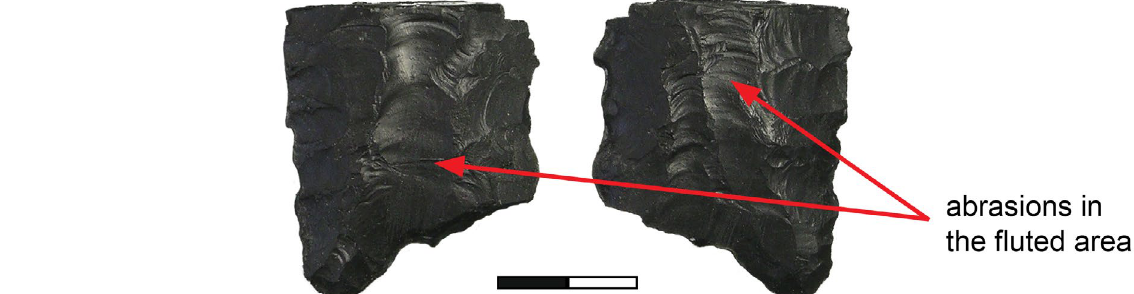
Figure 5. One of several Clovis-like fluted basal sections from the Borax Lake site, that displays the scratches in the fluted area on both faces (image after Slade 2016). The scale bar is 2cm wide (in 1 cm